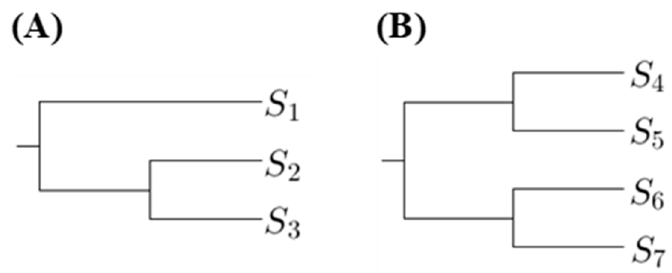
Figure 1. Two phylogenetic trees showing first clades ( A ) and second clades ( B ).